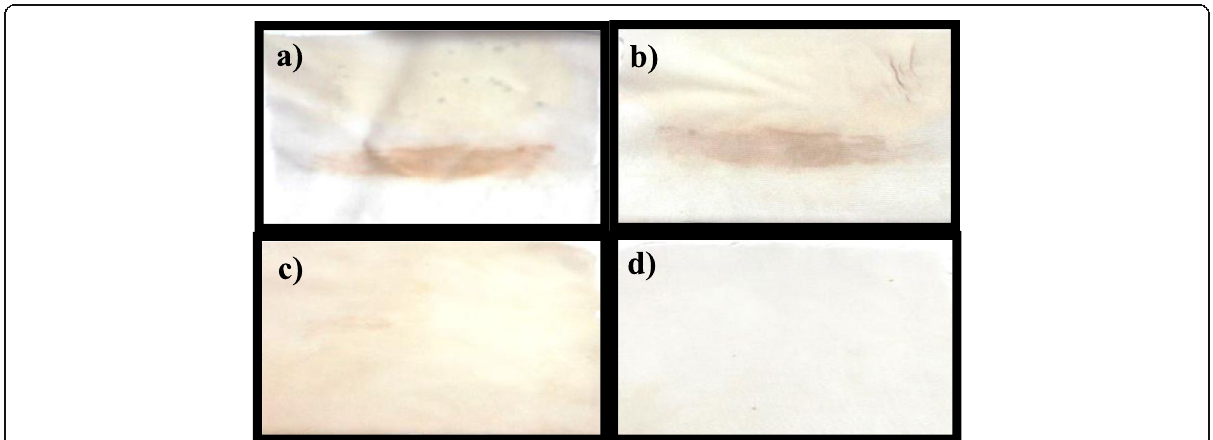
Fig. 8 Wash performance of R. oryzae R1 lipase in combination with Ariel [detergent] at 50 °C for 30 min at 200 rpm. a Cloth stained with chocolate and oil, b stained cloth washed with water only, c stained cloth washed with enzyme only, and d stained cloth washed with detergent and